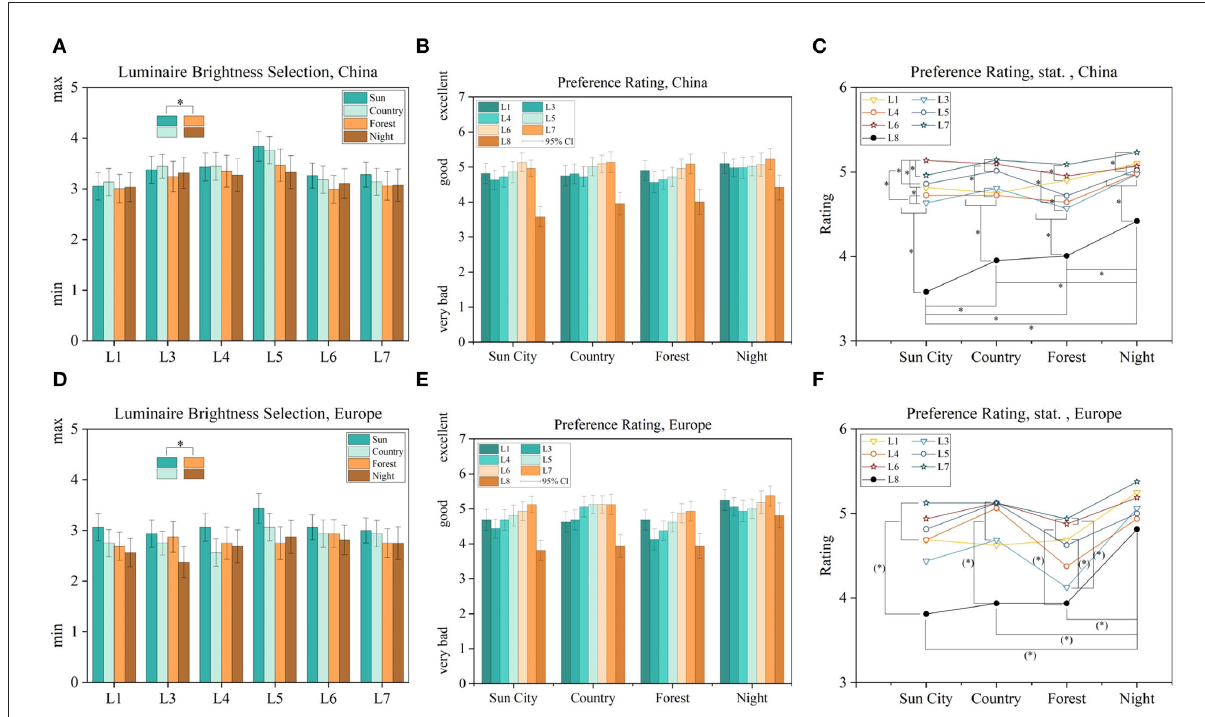
FIGURE6 Luminaire brightness selections between four different external sceneries (A,D) , its preference rating (B,E) and statistics of it (C,F) separated between Europe and China. Significances for p < 0.05 are marked with * or p < 0.08 as ( * ).